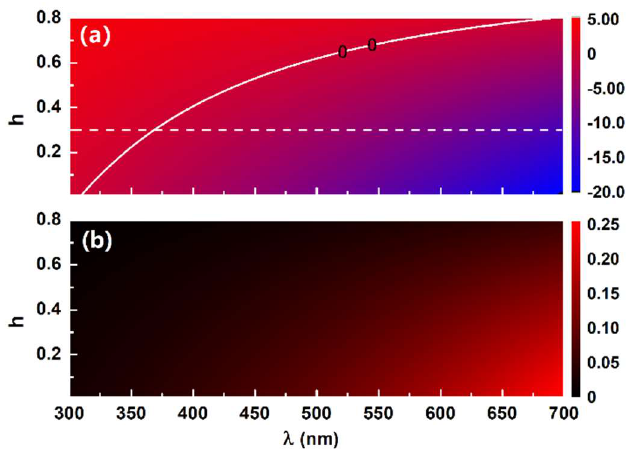
b  as a function of s